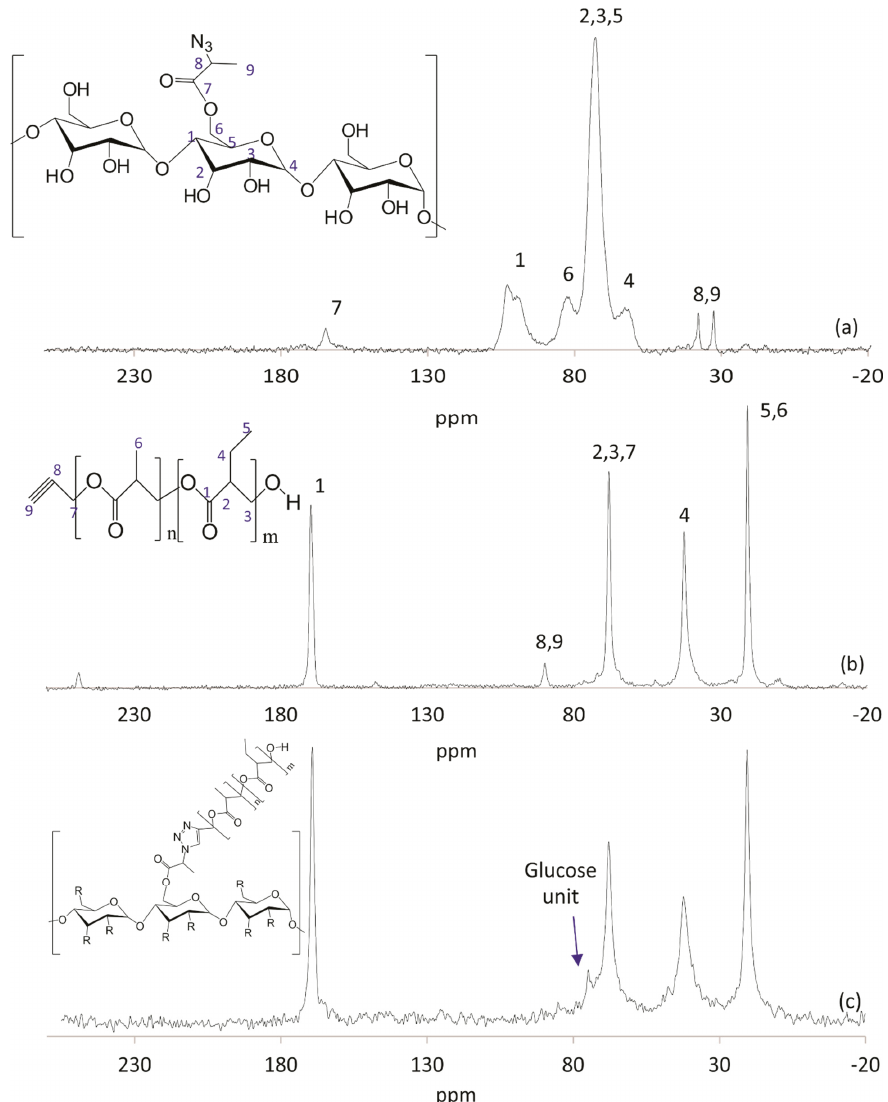
Figure 4. 110,5 MHz solid-state 13 C NMR spectra of PullN 3 [29] ( a ), PHBHV-alkyne ( b ) and Pull- g -PHBHV ( c ).